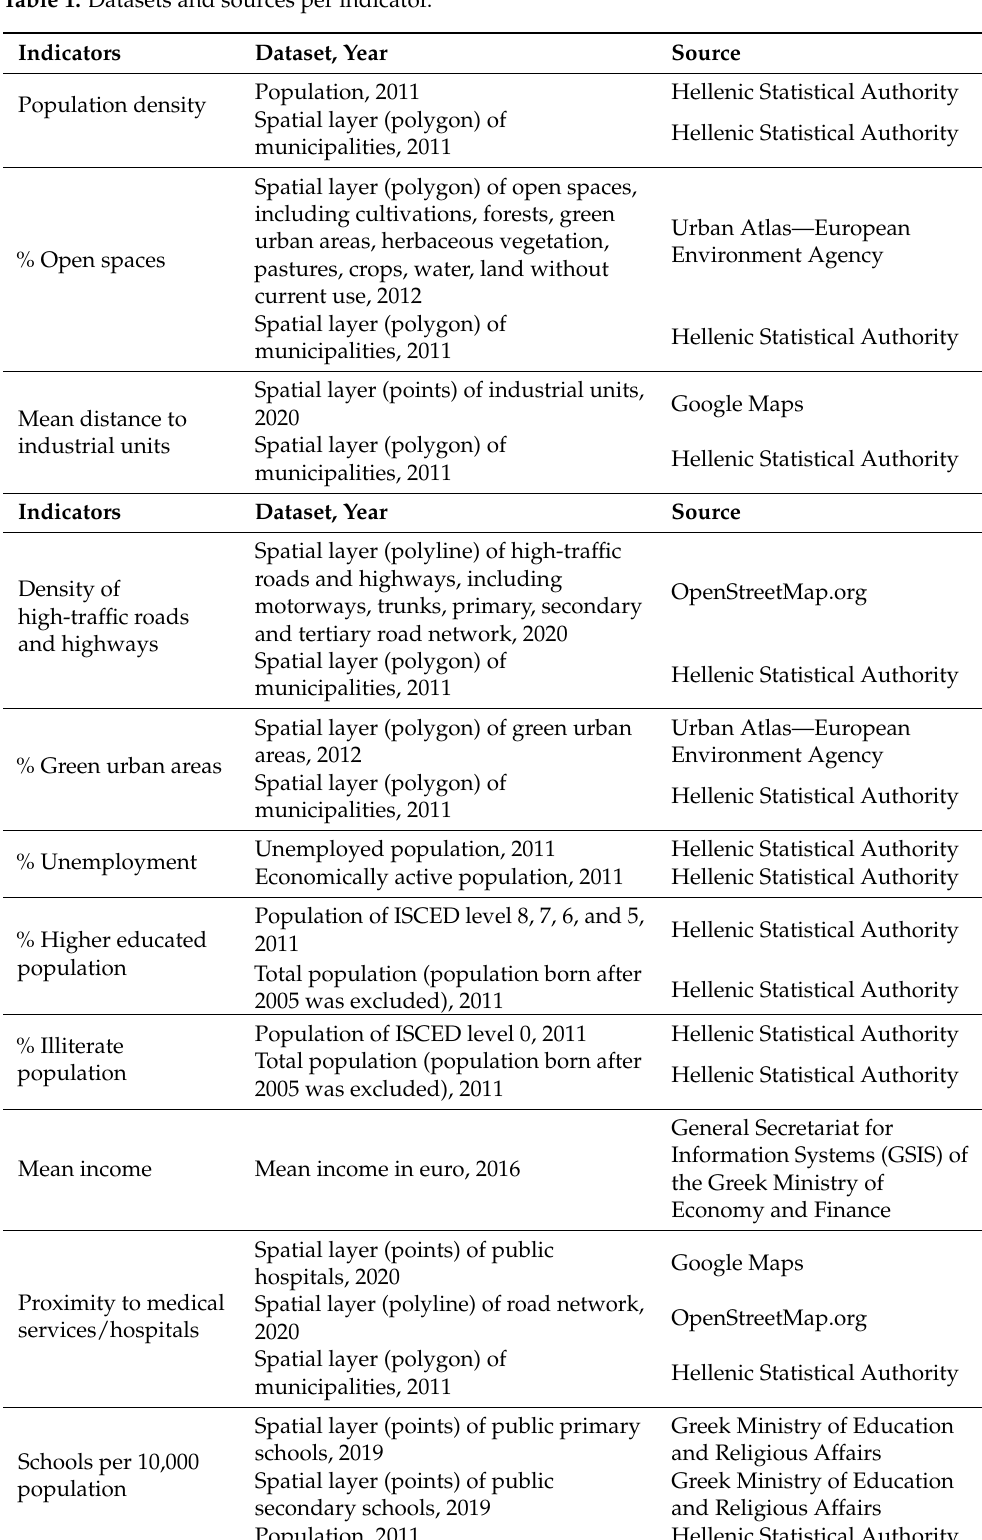
Table 1. Datasets and sources per